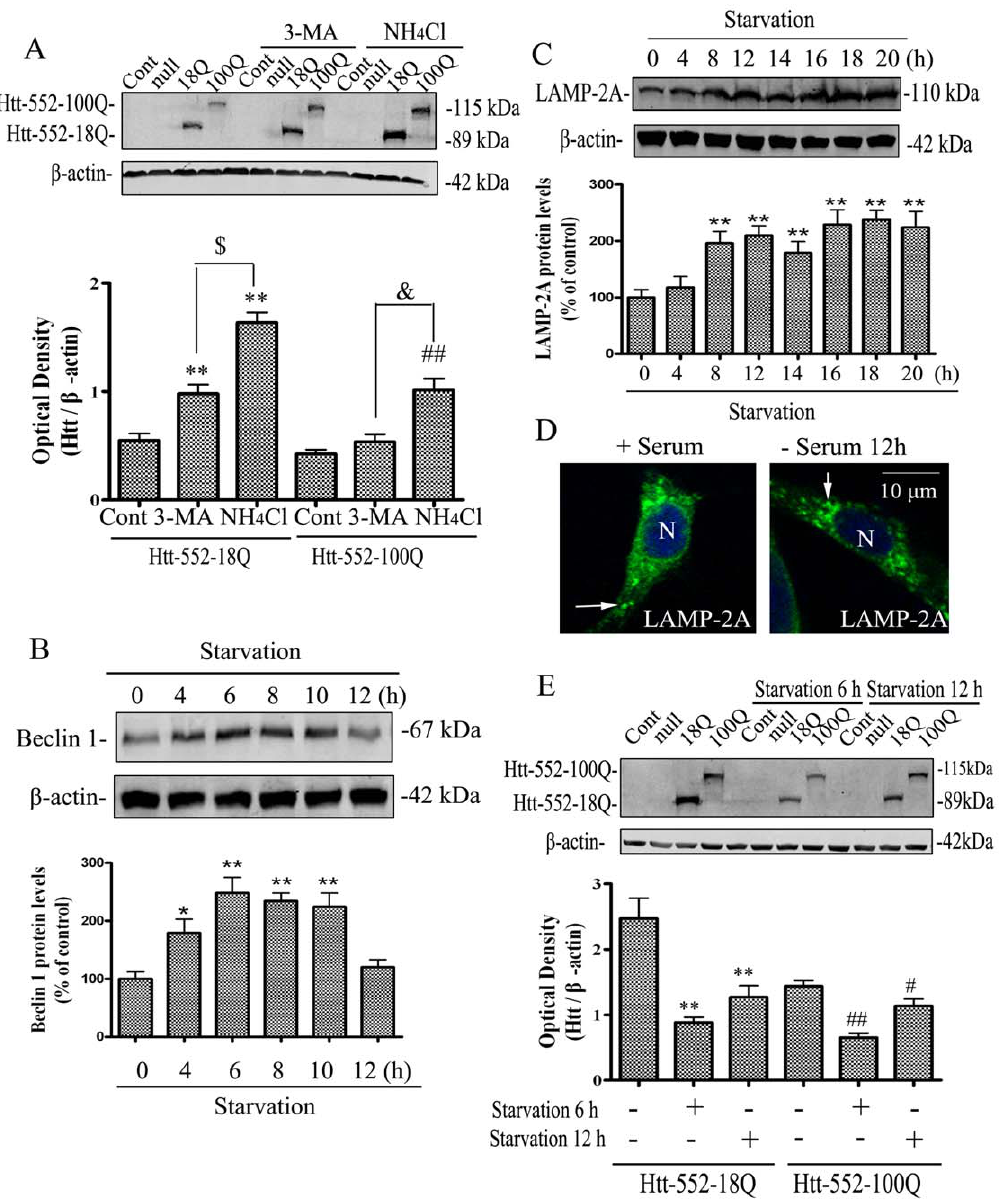
Figure 1. CMA is involved in degradation of Htt-552. (A) The effects of 3-MA and NH 4 Cl on the accumulation of Htt-552. Cells were transfected with Htt-552 for 48 h and then were treated with NH 4 Cl (15 mM) or 3-methyl adenine (3-MA, 10 mM) for 4 h. Cells were harvested and the effects of autophagy inhibitors on the accumulation of Htt-552 were determined with Western blot analysis. Values are the mean 6 SE of three independent experiments. **P , 0.01 (compared with Htt-552-18Q without treatment); ## P , 0.01 (compared with Htt-552-100Q without treatment); $ : p , 0.05 (Htt-552-18Q + 3-MA vs Htt-552-18Q + NH 4 Cl; &: p , 0.05 ((Htt-552-100Q + 3-MA vs Htt-552-100Q + NH4Cl); (B) The activations of macroautophagy induced by starvation as indicated by induction of Beclin 1. Starvation of PC12 cells were induced by removal of serum in the culture medium for indicated time. Values are the mean 6 SE of three independent experiments (*P , 0.05; **P , 0.01 vs 0 h). (C) The activations of CMA induced by starvation as indicated by induction of LAMP-2A. Values are the mean 6 SE of three independent experiments (**P , 0.01 vs 0 h). (D) The relocation of CMA-active lysosomes toward the nuclear regions in PC12 cells. Cells were maintained in the presence or absence of serum. After 12 h, cells were fixed and subjected to immunofluorescence for LAMP-2A. Representative cells for each condition. N: nucleus. Thin arrows point to lysosomes. The scale bar represents 10 m m. (E) Effects of starvation for 6 or 12 h on the degradation of Htt-552 in PC12 cells. The effects of these starvations on protein levels of Htt-552 protein were determined with Western blot analysis. Values are the mean 6 SE of three independent experiments. **P , 0.01 (compared with Htt-552-18Q without treatment); ## P , 0.01, # P , 0.05 (compared with Htt-552-100Q without treatment).